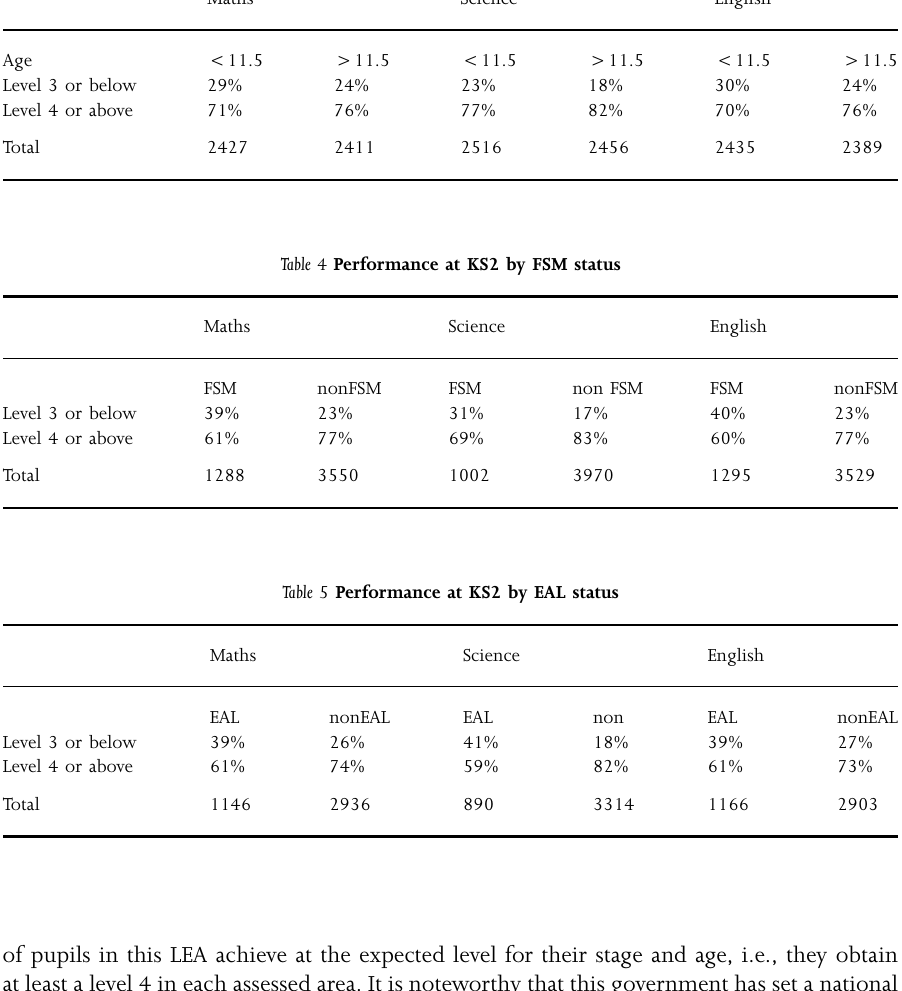
Table 3 Performance at KS2 by age (at the end of school year) Maths